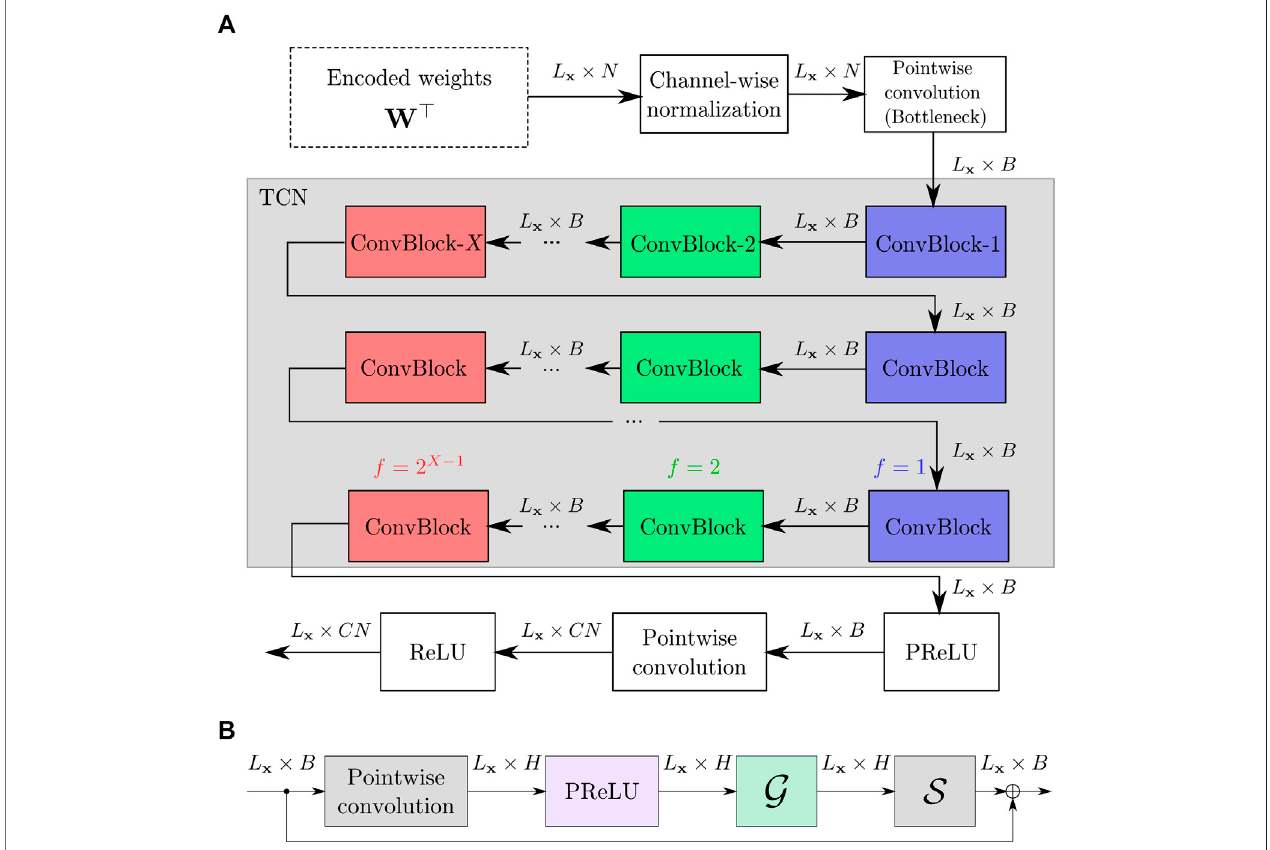
FIGURE 3 | (A) Temporal Convolutional Mask Estimation Network. (B) Network layers inside ConvBlock in Figure 3A . G ( F ) denotes the layer normalisation as de fi ned in (7) and S ( Y , K , L ) is the depthwise separable convolution as de fi ned in (14) .